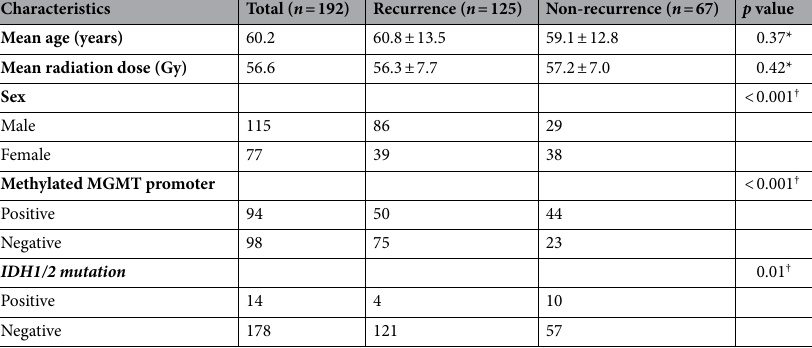
contrast-enhanced lesion, and non-enhancing T2 hyperintense lesion of tumor, overlaid on the CBV map. The overall workflow from image process to analysis is given in Fig. 2, and the obtained radiomic profile of recurrent glioblastoma patients ( n = 125) is given in Supplementary Fig. 1.